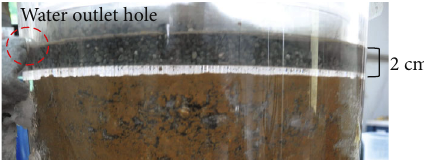
Figure 3: Maintain 2 cm of water head on the surface of the